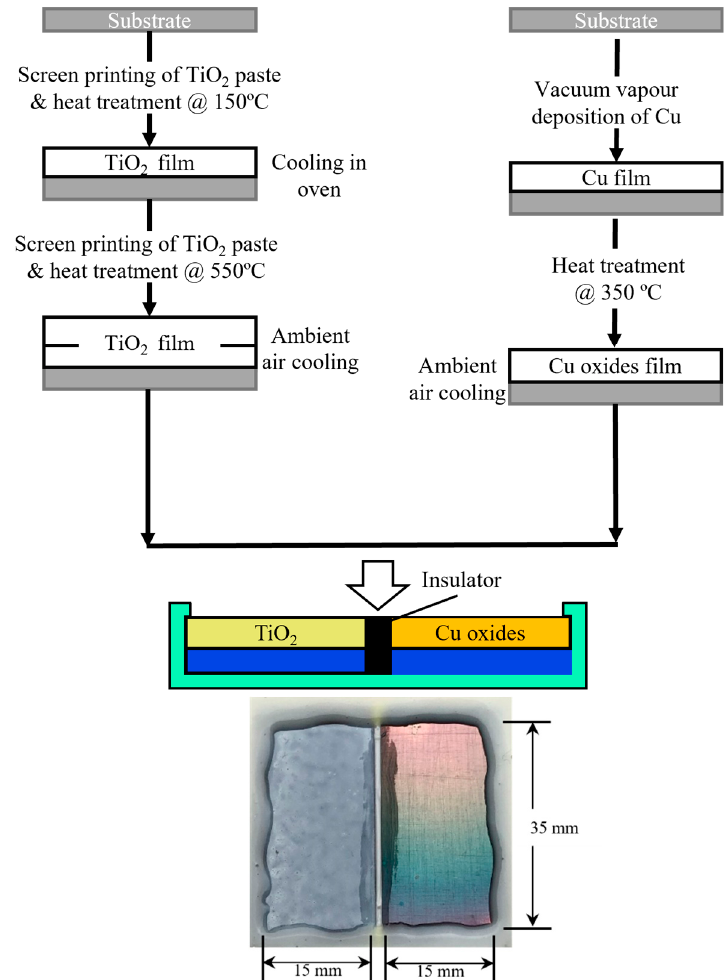
Figure 7. Preparation of each electrode of the TiO 2 –copper oxides cell, and its image.